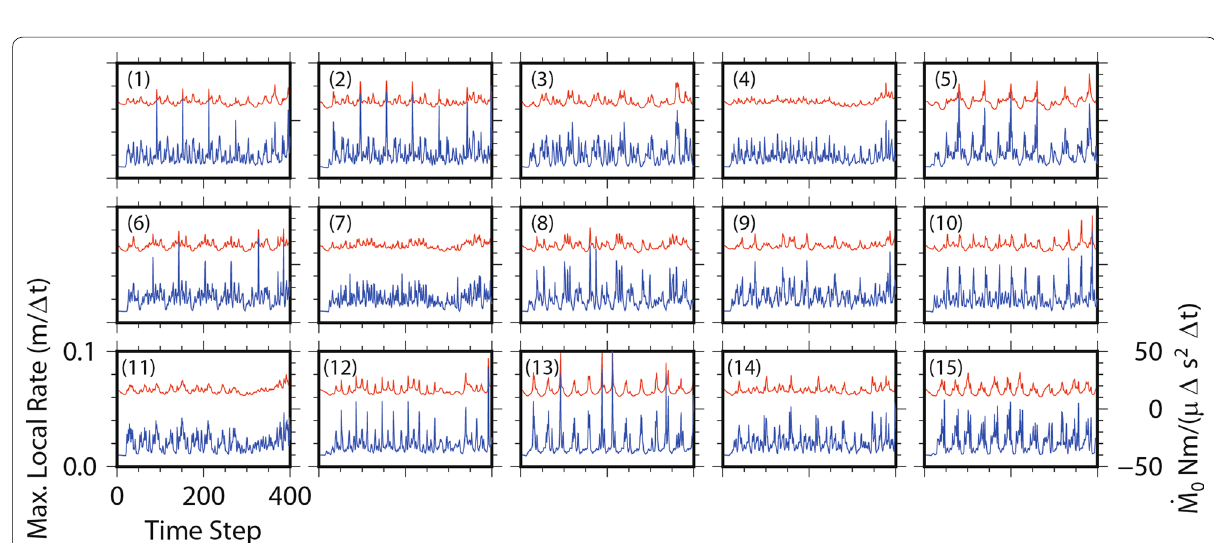
Fig. 8 Temporal evolution of all 15 simulations. The maximum slip rate at each time step is stated in blue ( left axis ), and ˙ M 0 from the whole area is in red ( right axis